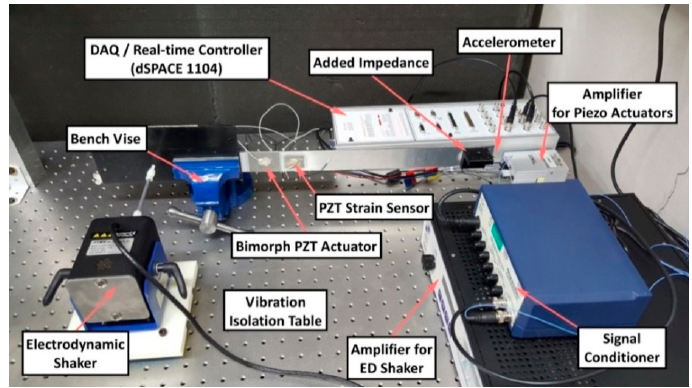
Figure 10. Experimental setup.